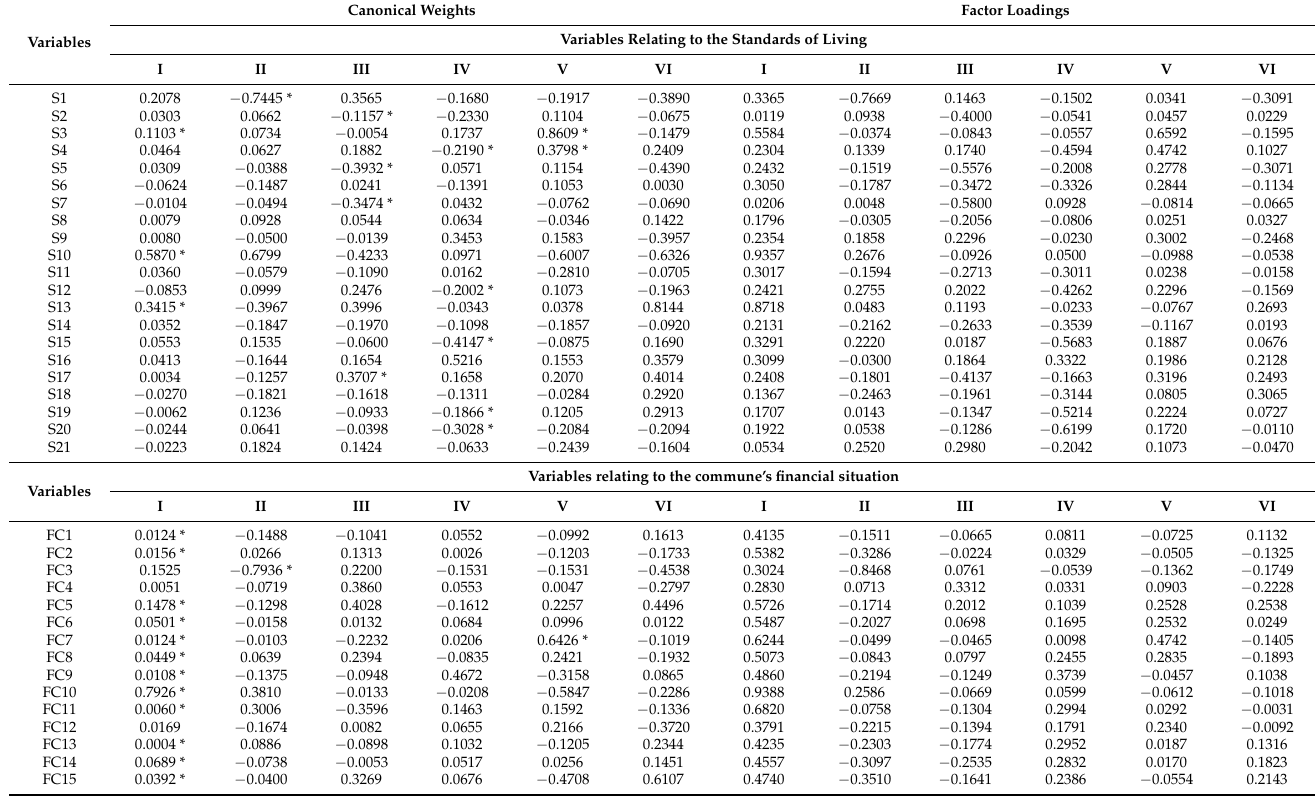
Table A1. Canonical weights and